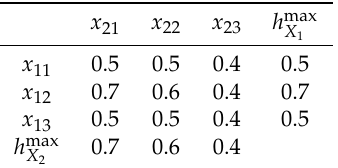
Table 5. Composition of the marginals in Table 4 using the min